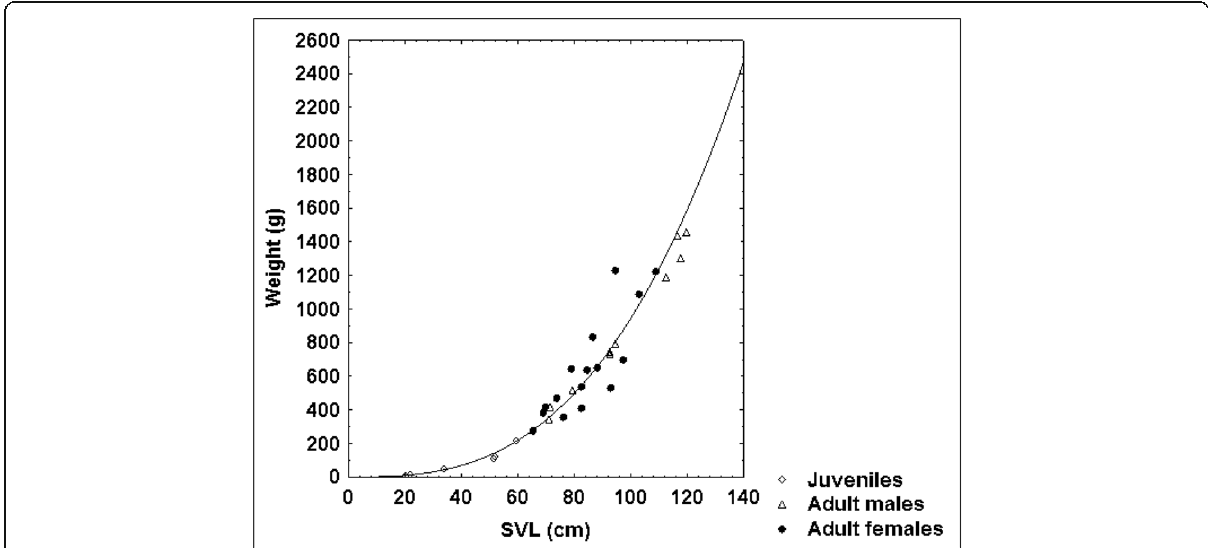
Fig. 7 Allometric relationship between SVL and weight in 34 blunt-nosed vipers from Cyprus: Y = exp.( − 6.32)*X 286